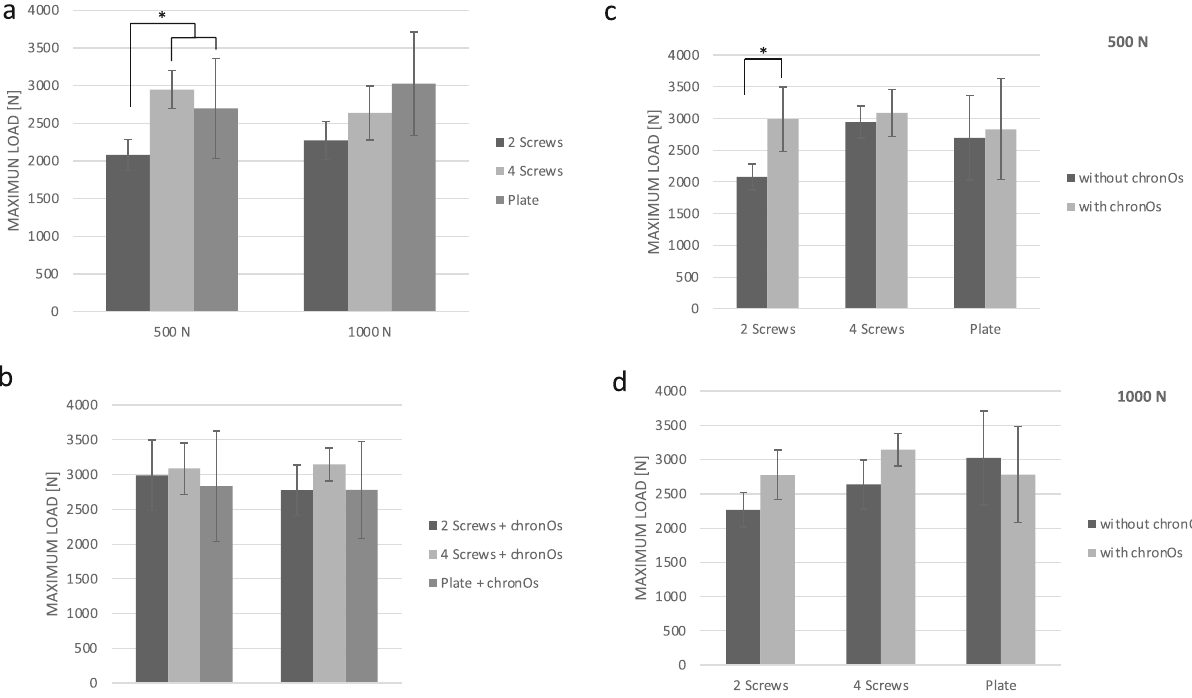
Figure 5. The results of the maximum load are demonstrated. Means ± SD, significant differences are indicated by *(p < 0.05 between groups). ( a ) A higher maximum load could be detected for the 4 screw and the plate osteosynthesis in the 500 N loading level compared to the 2 screw osteosynthesis, all without bone filler. ( b ) Comparing the three types of osteosynthesis with bone cement to each other, no differences were distinguished. ( c ) A higher maximum load for the combination with ChronOs™ inject revealed the two screw osteosynthesis whereas no differences were determined for the 4 screw and the plate osteosynthesis in the 500 N level. ( d ) No differences were detected between the different types of osteosyntheses without bone cement compared to the same type in combination with bone cement in the 1000 N testing